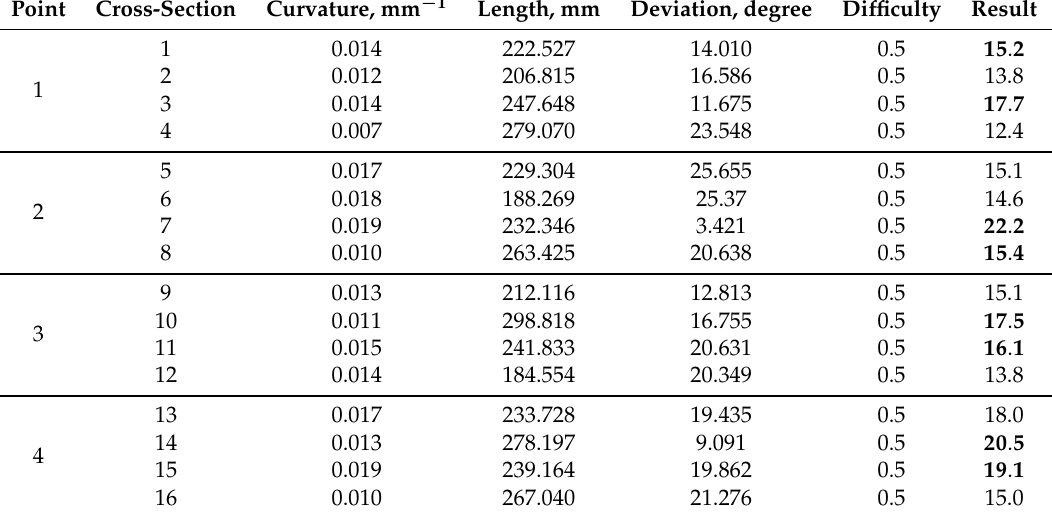
Table 4. The selected results of simulation investigations being the basis for selecting the scanning lines for the second free-form surface.